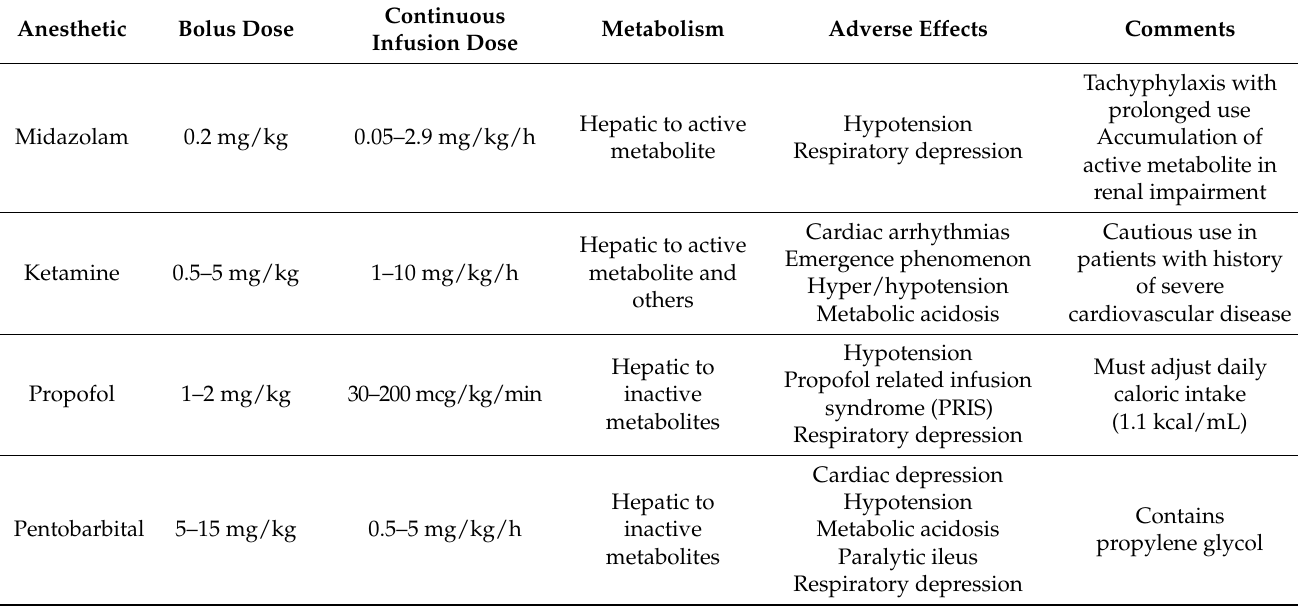
Table 2. Continuous anesthetic infusions for the treatment of RSE and